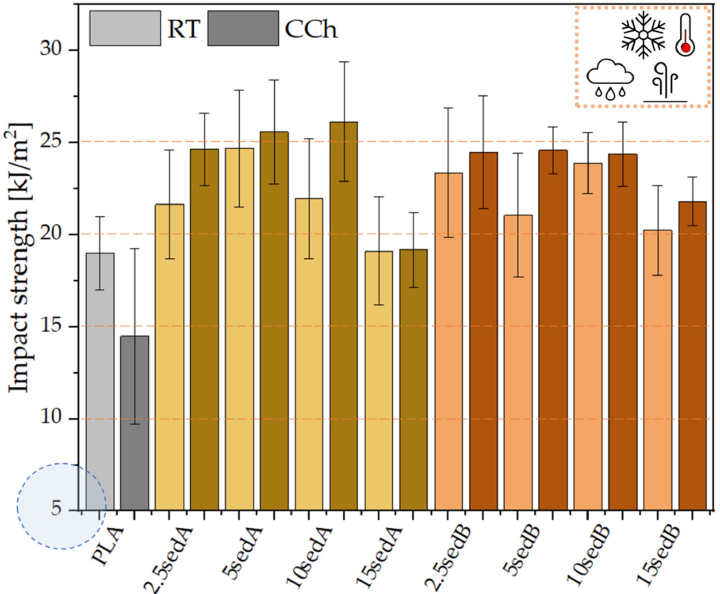
Figure 13. Impact strength for composites after conditioning in the weathering chamber (WCh).